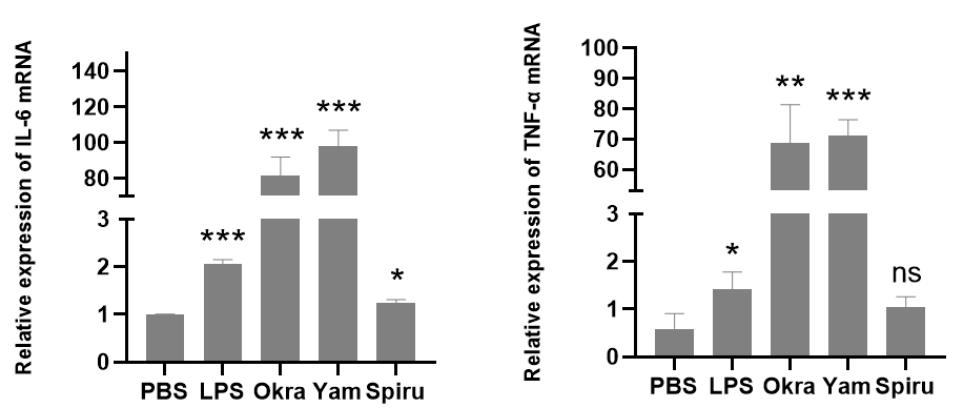
Figure 8. Effects of polysaccharides on RAW 264.7 cells. The RAW 264.7 cells were cultured, and the corresponding substances were added after starvation for 8 h. After incubation for 24 h, the cells were lysed to extract RNA and reverse transcribed into cDNA, and the mRNA levels of IL-6 and TNF- α were detected via qPCR. * p < 0.05; ** p < 0.01; *** p < 0.001; ns, no significance.